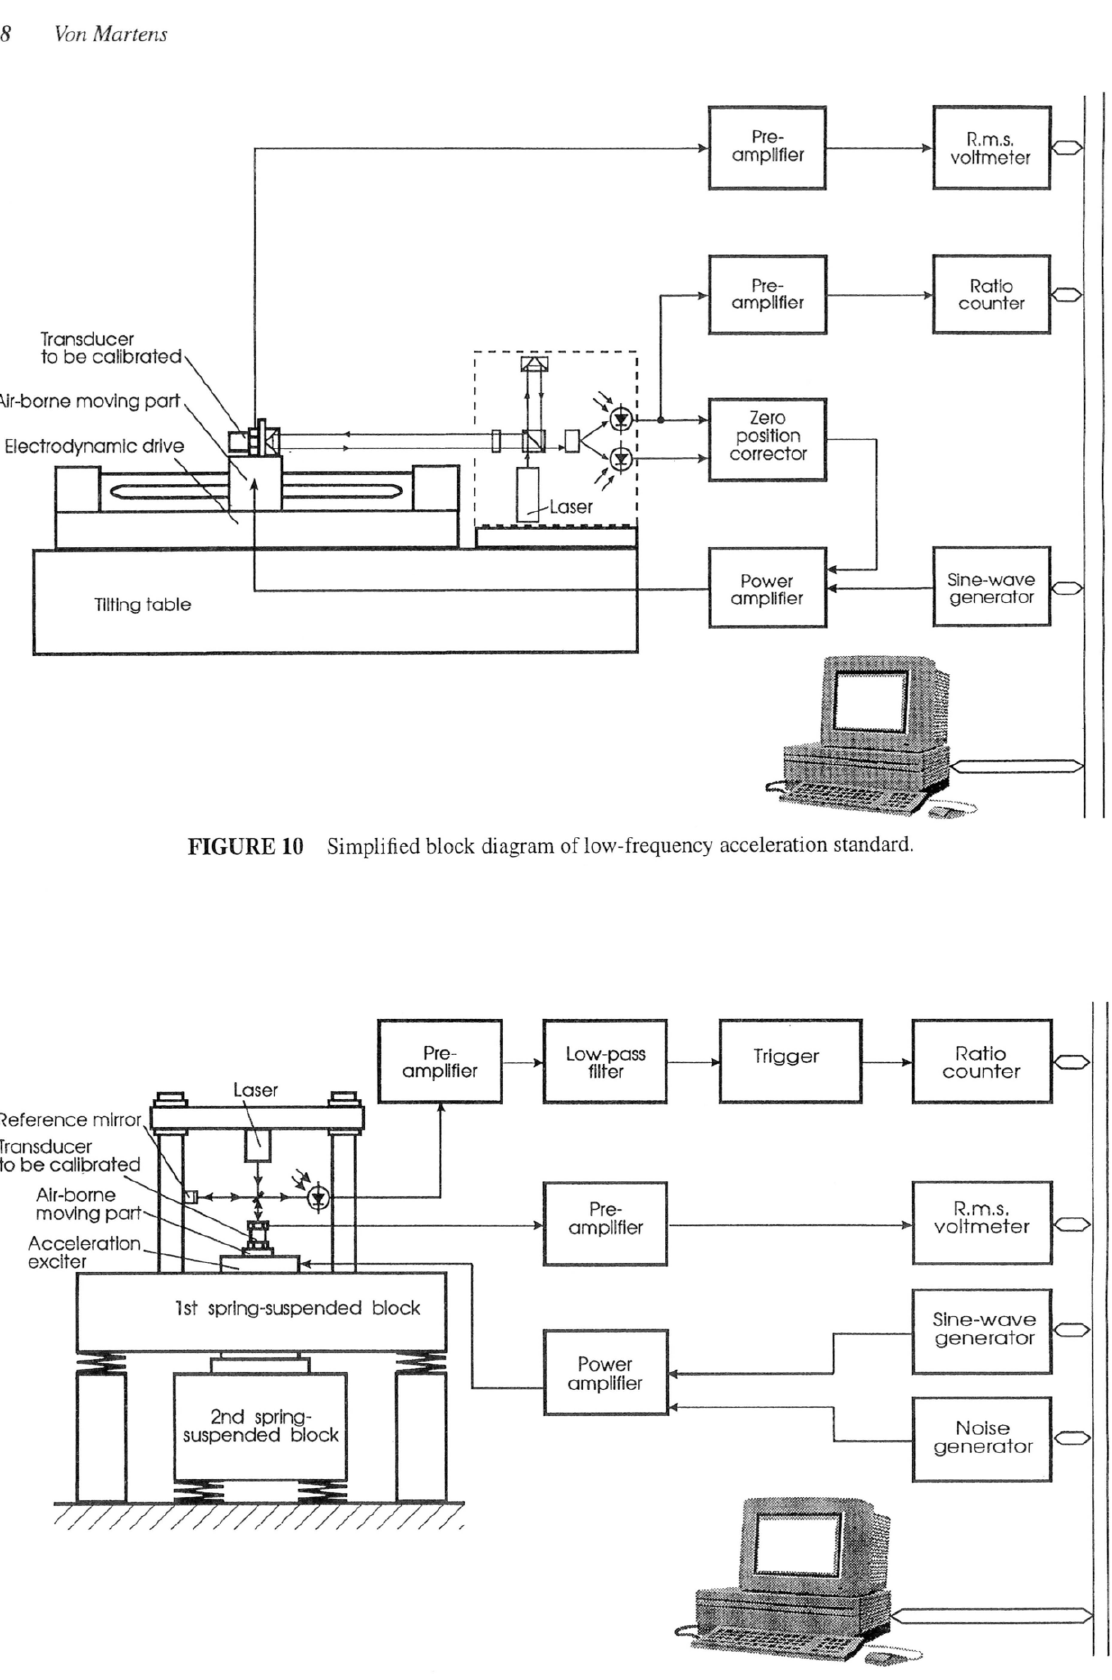
FIGURE 11 Simplified block diagram of middle-frequency acceleration